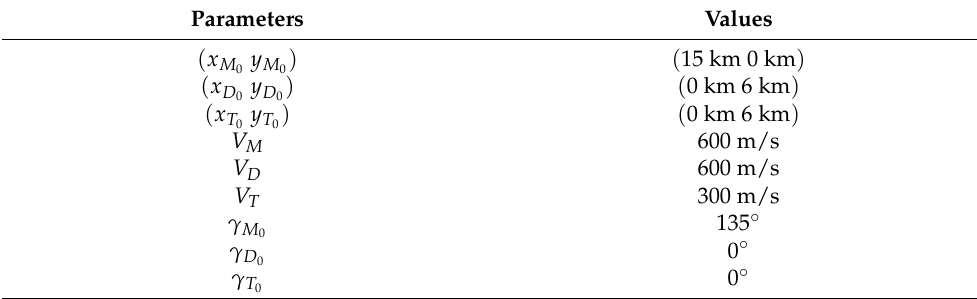
Table 1. Initial